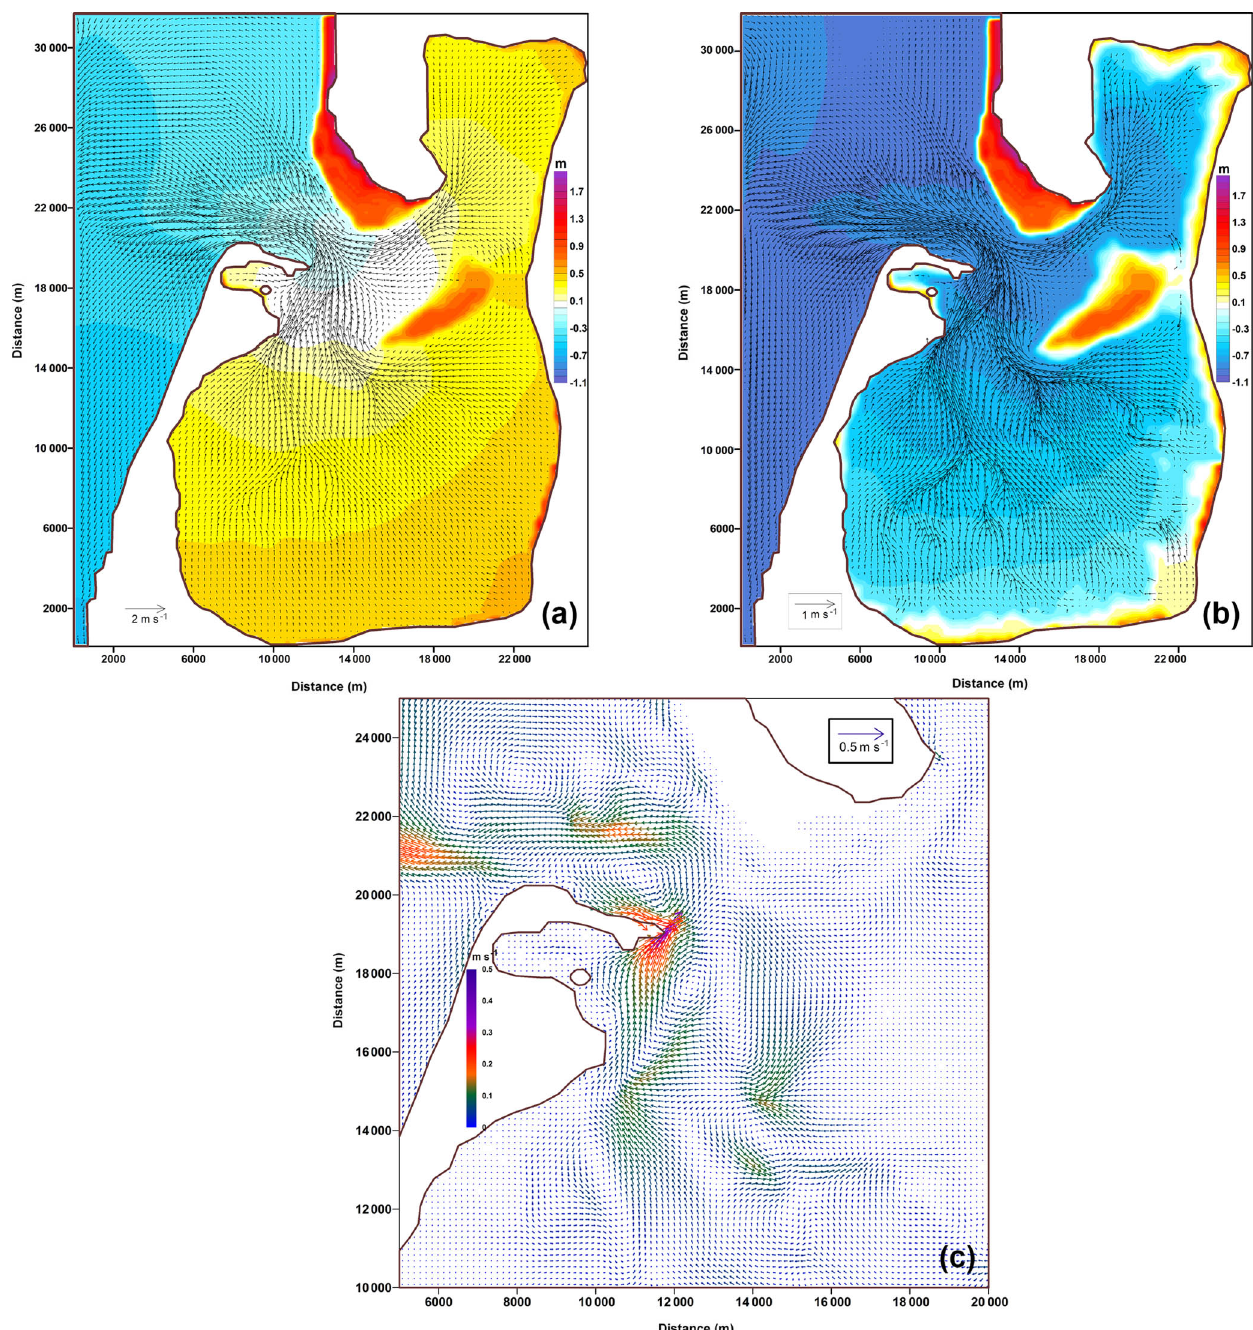
Figure 4. (a) Full ebb; (b) low water; (c) the residual circulation. Simulation was performed on MESH-1.